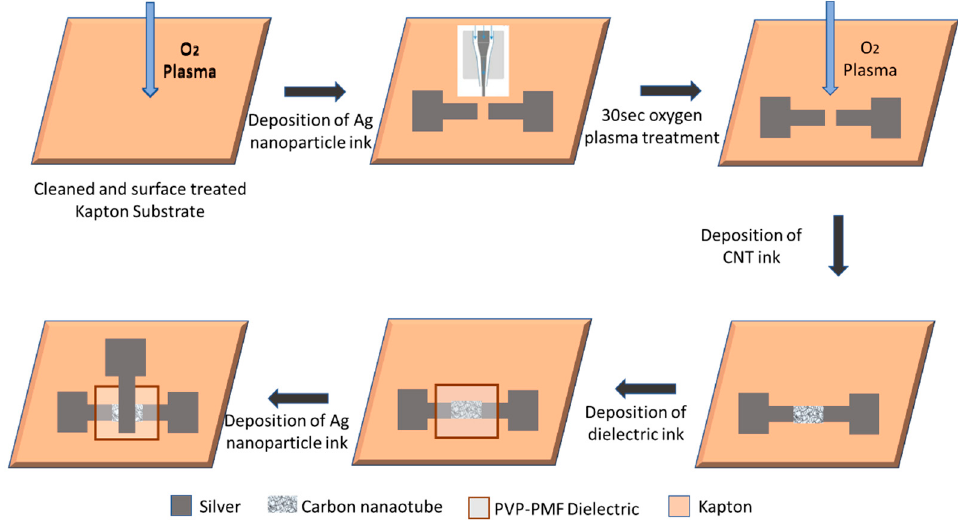
Figure 1. Detailed diagram of CNT TFT fabrication process on Kapton substrate using aerosol jet printing.